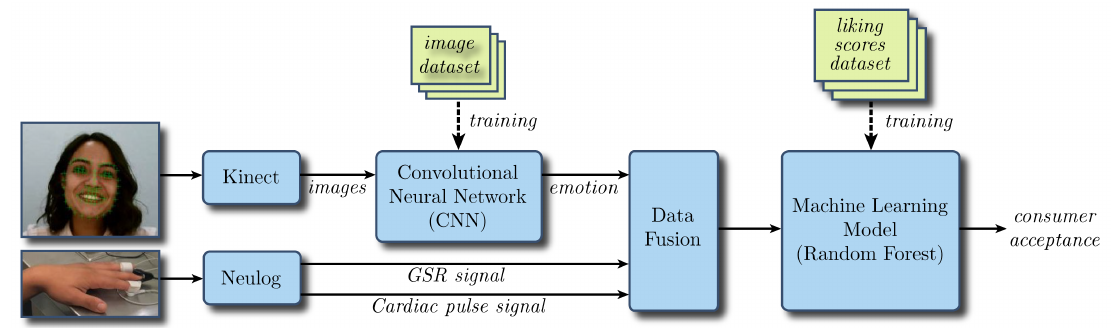
Figure 4. The sensory analysis system architecture. GSR, galvanic skin response.